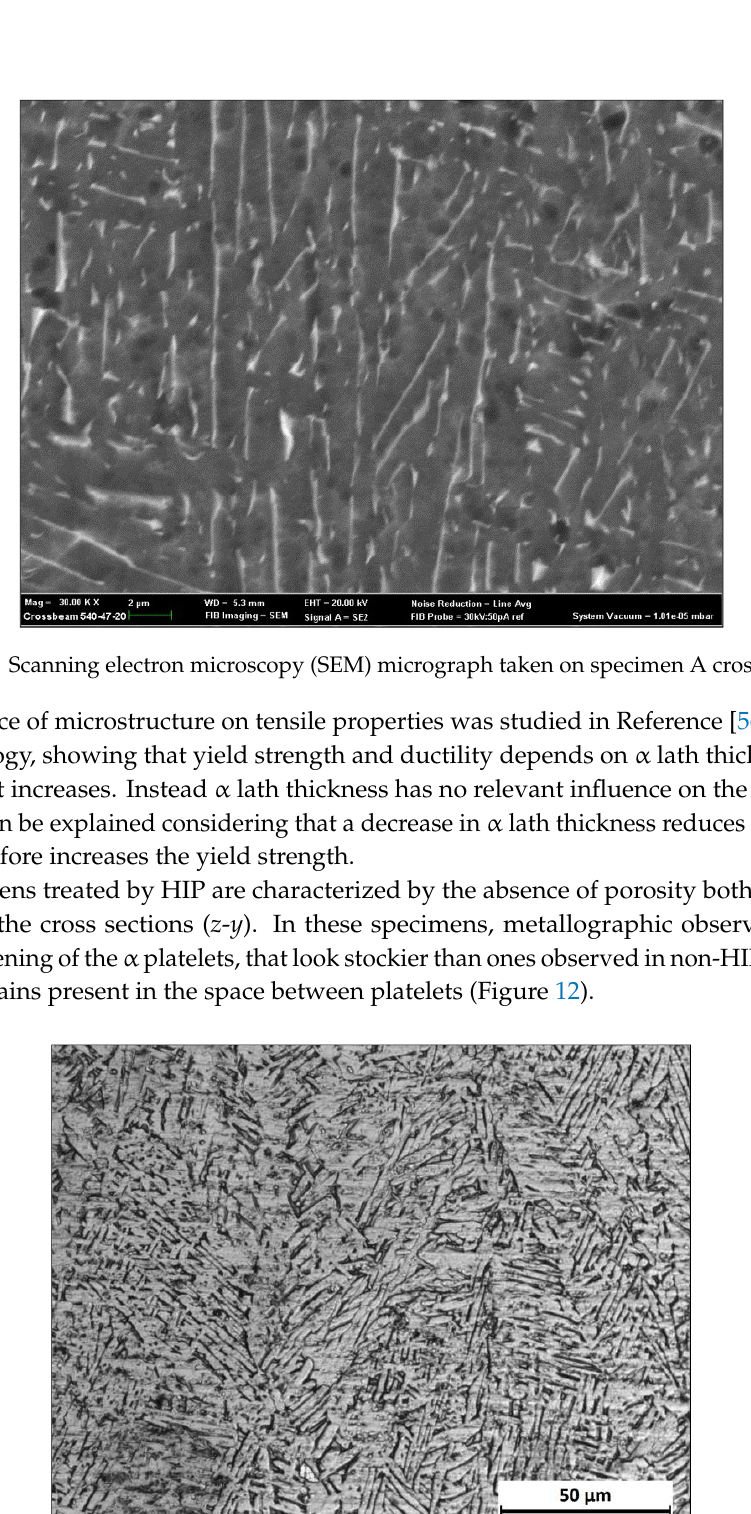
Figure 13. X-ray diffraction (XRD) pattern of an as-built specimen; the red lines indicates the characteristic diffraction peaks of the α phase. 3.4. Mechanical Properties At room temperature the 0.2% offset yield strength is about 740 MPa, the ultimate strength 800 MPa, elongation is below 10% and necking negligible. The experimental points in Figure 14 are representative of mean values: the results variability was in the range of 15% for ductility ( ε ) and 7% for yield strength ( σ y ) and ultimate tensile strength ( σ UTS ). At the increasing of test temperature, ductility increases reaching a value equal to 30% at 800 °C, while mechanical strength decreases